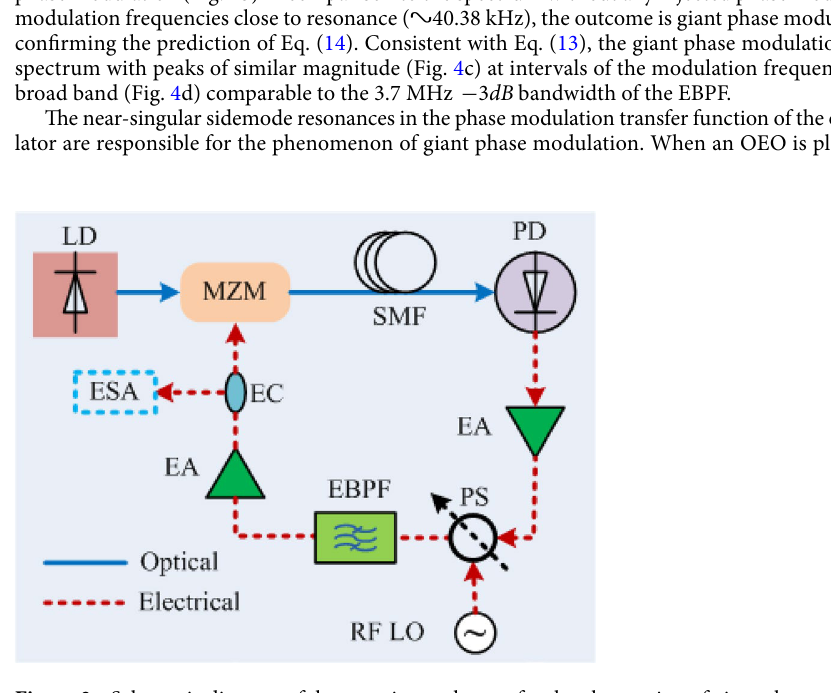
Figure 3. Schematic diagram of the experimental setup for the observation of giant phase modulation. LD Laser diode, MZM Mach–Zehnder modulator, SMF Single mode fiber, PD Photodiode, EA Electrical